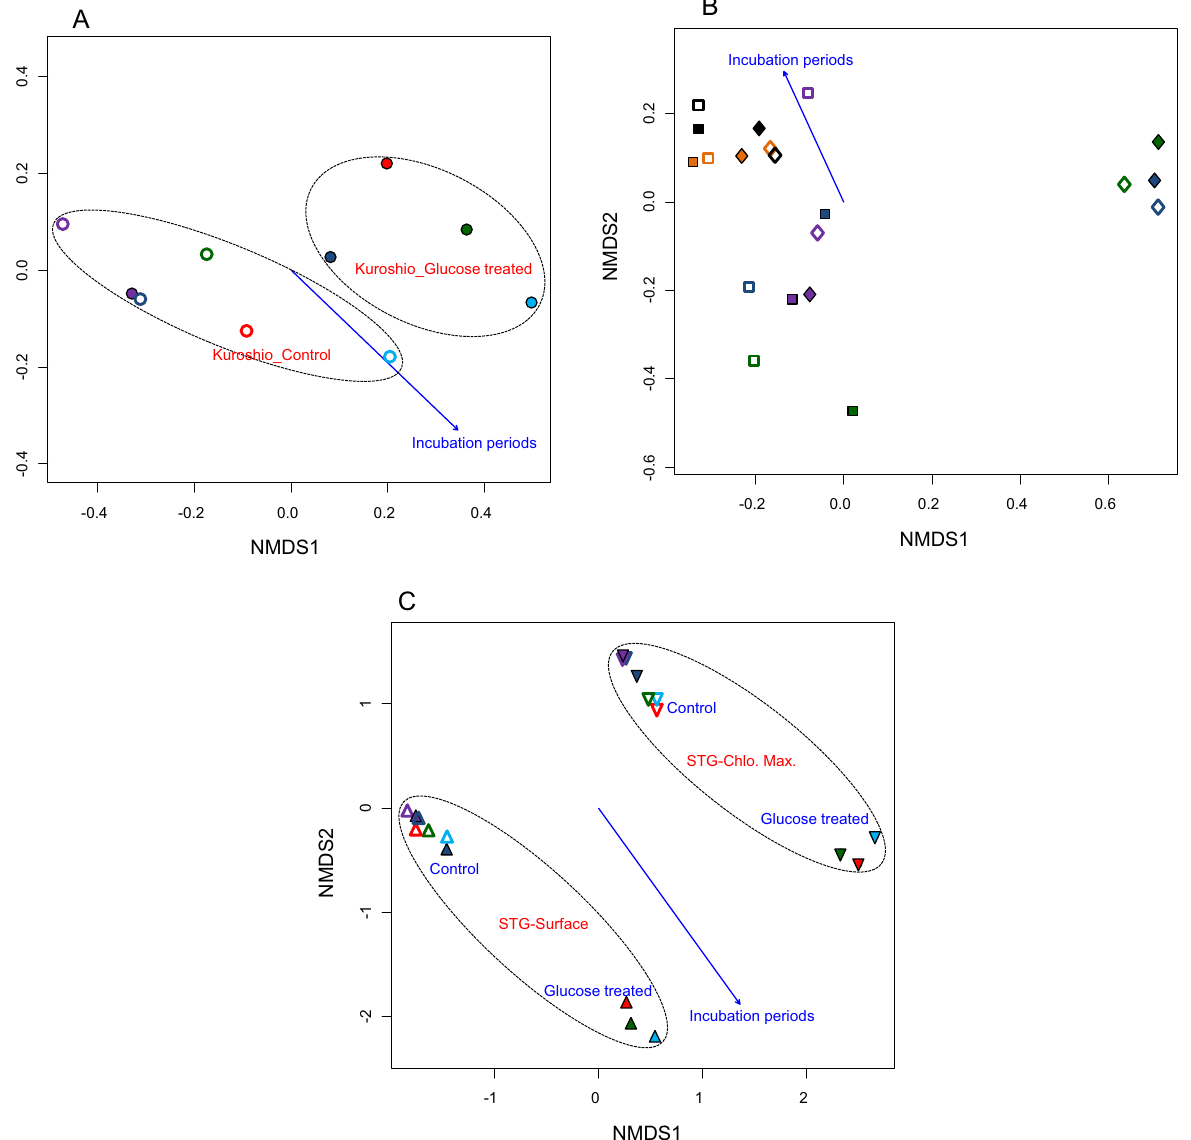
Figure 5. Non-metric Multidimensional Scaling fitting with the incubation conditions (periods and temperatures), and glucose treatment (treated and control) showing the clustering of the samples from each station separately; ( A ) samples of Kuroshio Current; ( B ) samples of North Pacific Sub-polar Gyre, SPG (Surface = surface water, Chlo. Max. = Chlorophyll maximum water); and ( C ) samples of North Pacific Sub- tropical Gyre, STG (Surface = surface water, Chlo. Max. = Chlorophyll maximum water) in the western North Pacific Ocean. Water samples of the Kuroshio Current, SPG-surface, SPG-chlorophyll maximum, STG-surface water, and STG-chlorophyll maximum are presented respectively by the symbols circle, square, diamond, triangle, and inverted triangle; the symbols in purple, dark blue, red, green, light blue, orange, and black indicating incubation periods of 12 h, 24 h, 36 h, 48 h, 60 h, 72 h, and 96 h, respectively; filled symbols are for treated and unfilled symbols are for control